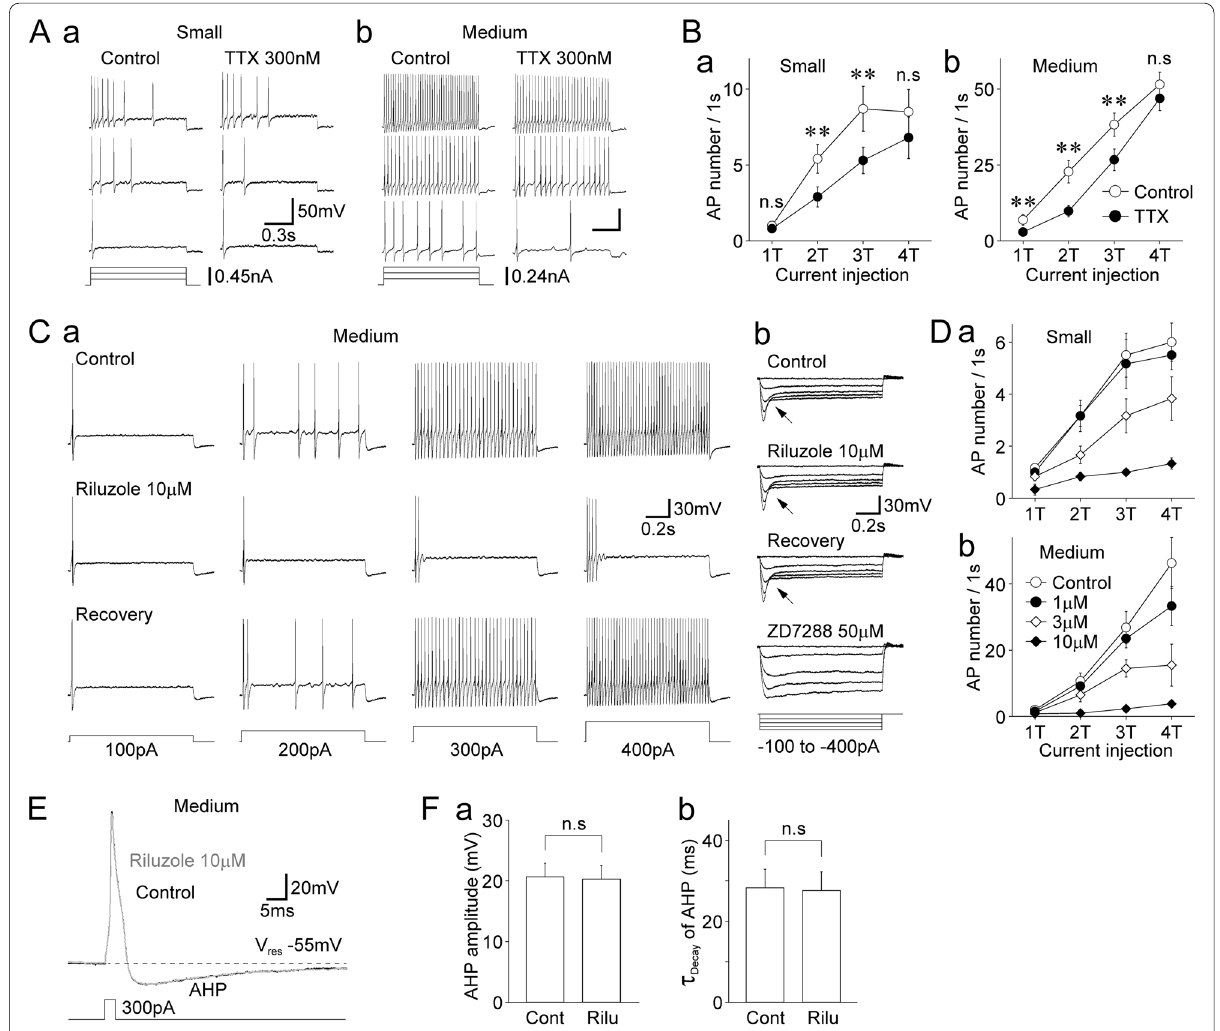
Fig. 6 Contribution of TTX‑R I NaP to the excitability of dural afferent neurons. A. Typical voltage traces in response to depolarizing current injections in the absence (left) and presence (right) of 300 nM TTX in small‑ ( a ) and medium‑sized ( b ) DiI‑positive neurons. Three representative raw traces were elicited by one‑fold threshold (1 T; 150 and 80 pA in small‑ and medium‑sized neurons, respectively) to three‑fold threshold depolarizing current injections. Phasic and tonic firing patterns are shown for small‑ and medium‑sized DiI‑positive neurons, respectively. B. Changes in the number of action potentials elicited by depolarizing current injections (1 T to 4 T) in the absence (open circles) and presence (closed circles) of 300‑nM TTX in small‑ ( a ) and medium‑sized ( b ) DiI‑positive neurons. The points and error bars represent the mean and SEM from 25 small‑ and 31 medium‑sized DiI‑positive neurons. **; p < 0.01, n.s; not significant (paired t‑test). C. a , Typical voltage traces in response to depolarizing current injections recorded before (upper), during (middle), and after (lower) the application of 10 μM riluzole. Four representative raw traces were elicited by one‑fold threshold (1 T; 100 pA) to four‑fold threshold (4 T; 400 pA) depolarizing current injections in medium‑sized DiI‑positive neurons. b , Typical voltage traces in response to hyperpolarizing current injections recorded before (upper), during (middle), and after (lower) the application of 10 μM riluzole in the same neuron shown in Ca. Notably, 50 μM ZD7288 but not 10 μM riluzole greatly attenuated sag potentials (arrows). D. Changes in the number of action potentials elicited by depolarizing current injections (1 T to 4 T) in the absence (open circles) and presence of riluzole (1, 3, and 10 μM) in small‑ ( a ) and medium‑sized ( b ) DiI‑positive neurons. The points and error bars represent the mean and SEM from six small‑ and six medium‑sized DiI‑positive neurons. E. Typical action potentials elicited by brief depolarizing current injections (3 ms duration, 300 pA) in the absence (black) and presence (gray) of 10 μM riluzole in medium‑sized DiI‑positive neurons. Note that riluzole (10 μM) did not affect the afterhyperpolarization (AHP) of action potentials. F. Riluzole (10 μM)‑induced changes in the amplitude of AHP ( a ) and decay time constant of AHP ( b ) in medium‑sized DiI‑positive neurons. The columns and error bars represent the mean and SEM from six medium‑sized DiI‑positive neurons. n.s; not significant (paired